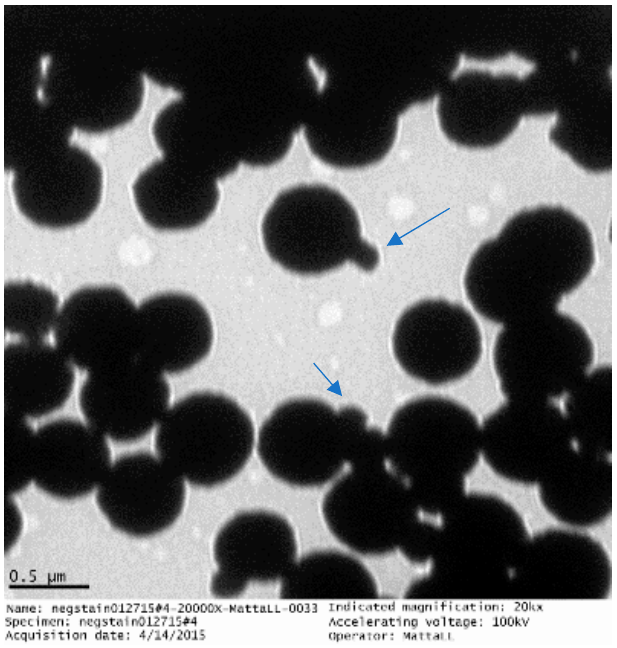
Figure 2. Transmission electron microscope (TEM) image of glycan-coated magnetic nanoparticle clusters, with several iron oxides enclosed in the glycan polymer. Some nanoparticles are protruding from the cluster (See arrows). (TEM image by the Nano-Biosensors Lab, Michigan State University.) Five hundred sputum samples that were obtained from 500 patients were included in the